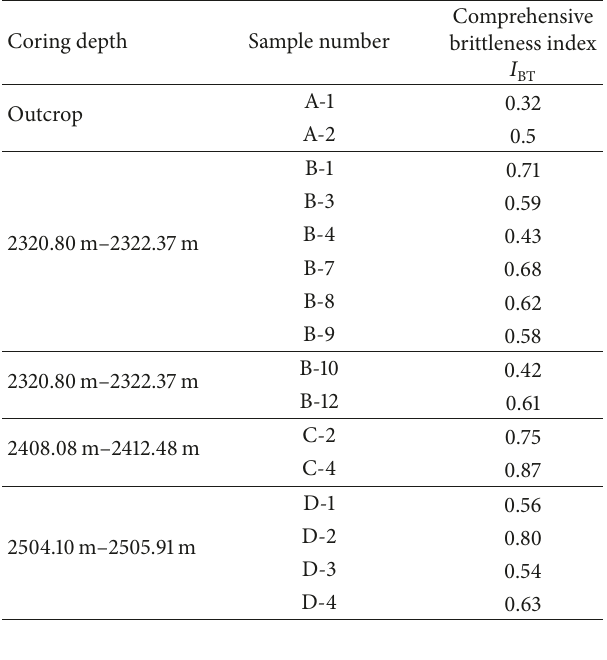
Table 3: Comprehensive brittleness index of shale.